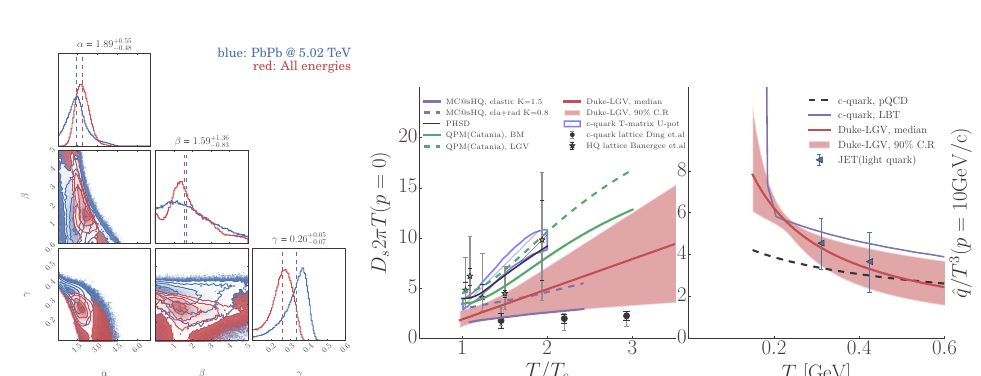
Figure 2: (Color online) left: Posterior distributions of parameters ( α, β, γ ); right: the heavy quark di ff usion coe ffi cients estimated by taking the posterior samples, compared with other models’ calcu-